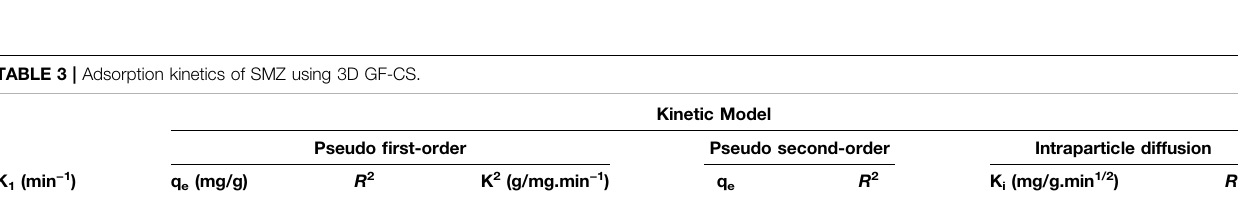
FIGURE 10 | Adsorption kinetics of SMZ using 3D GF-CS (A) pseudo- fi rst-order, (B) pseudo-second-order, and (C) intraparticle diffusion.